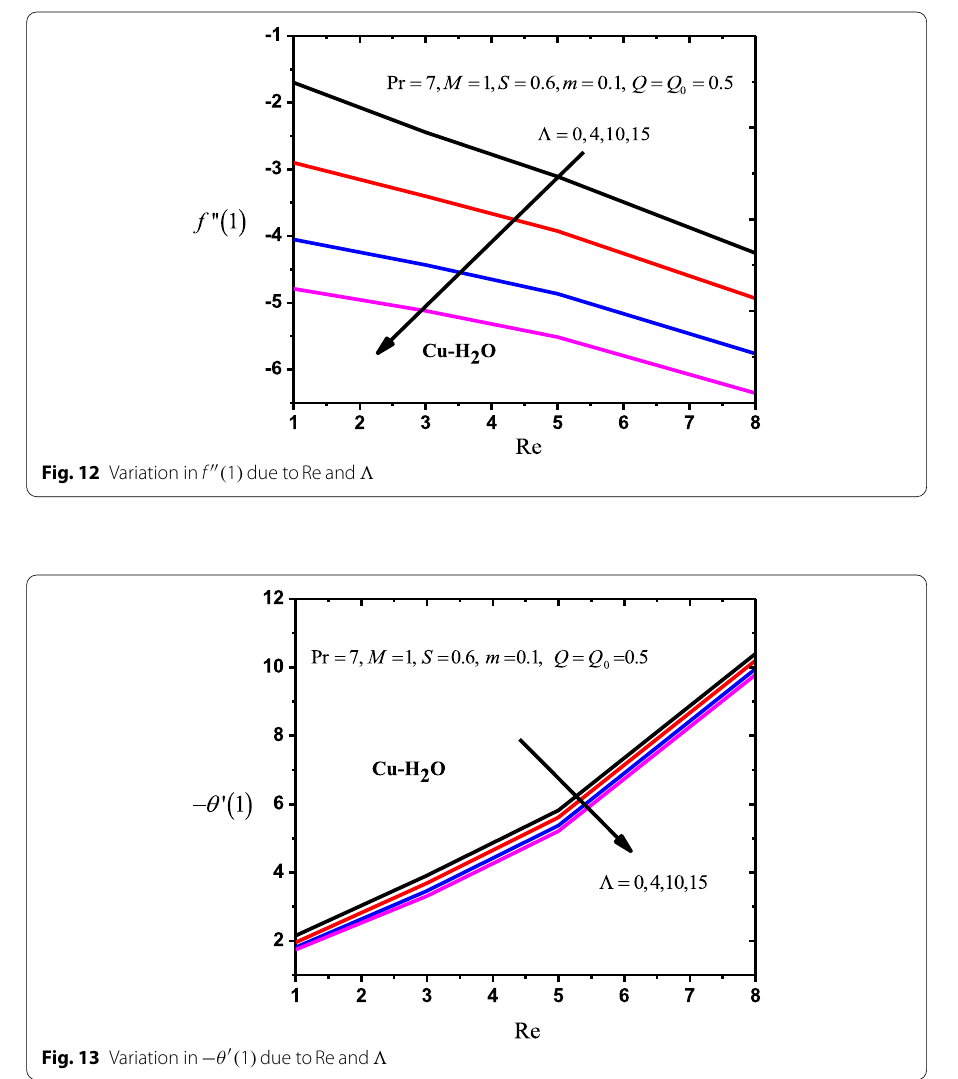
Fig. 13 Variation in